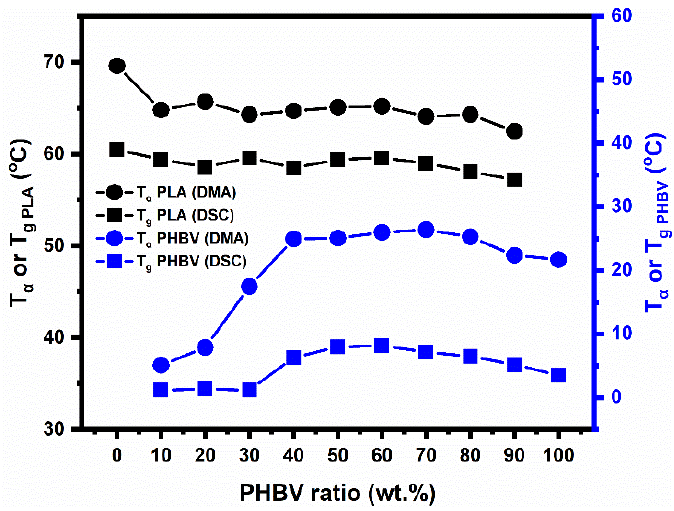
Figure 7. Glass transition temperature of PLA/PHBV blends as determined by DSC (square) and DMA (circles).